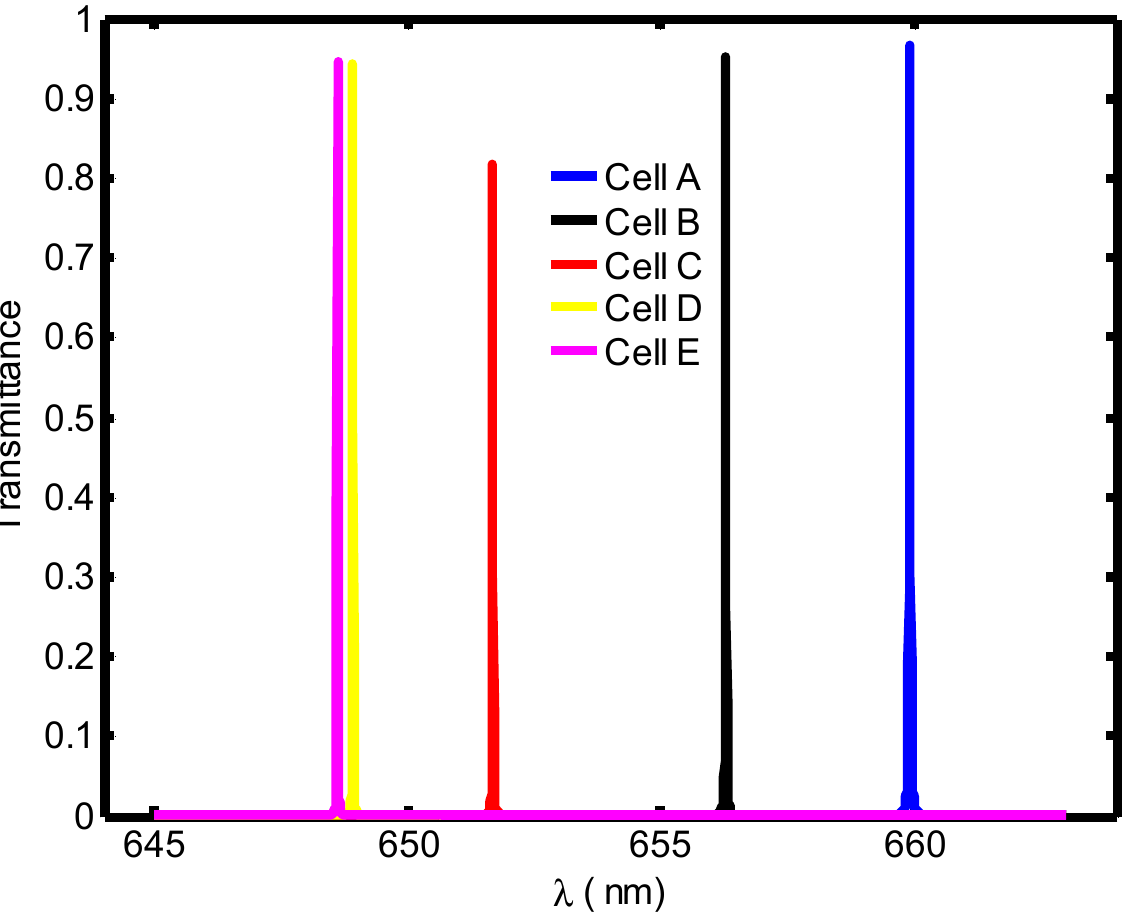
Figure 7. Transmission spectra showing five defect modes in solid blue, black, brown, yellow and purple line colors corresponding to RBC sample containing A, B, C, D and E blood cells separately, one at a time. The thickness of cavity layer is dd = 3000 nm under normal incidence. Table 2. Sensitivity calculations of proposed biosensors corresponding to different defect layer thicknesses.